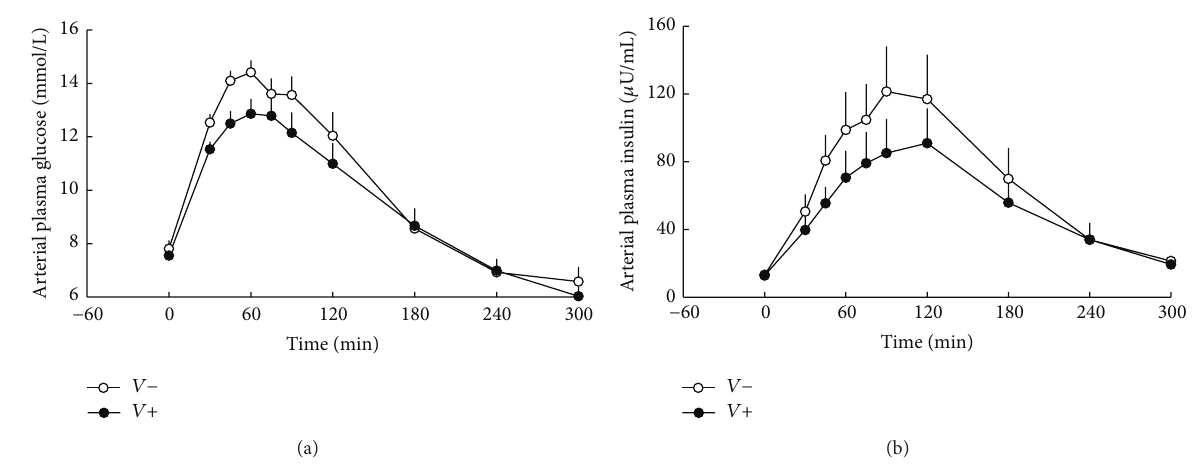
Figure 1: Arterial plasma glucose ( 𝑝 = 0.0279 ) (a) and insulin ( 𝑝 = 0.0457 ) (b) levels in subjects consuming vinegar ( V +) or placebo ( V − ). At 𝑡 = 0 min, a mixed meal was given.